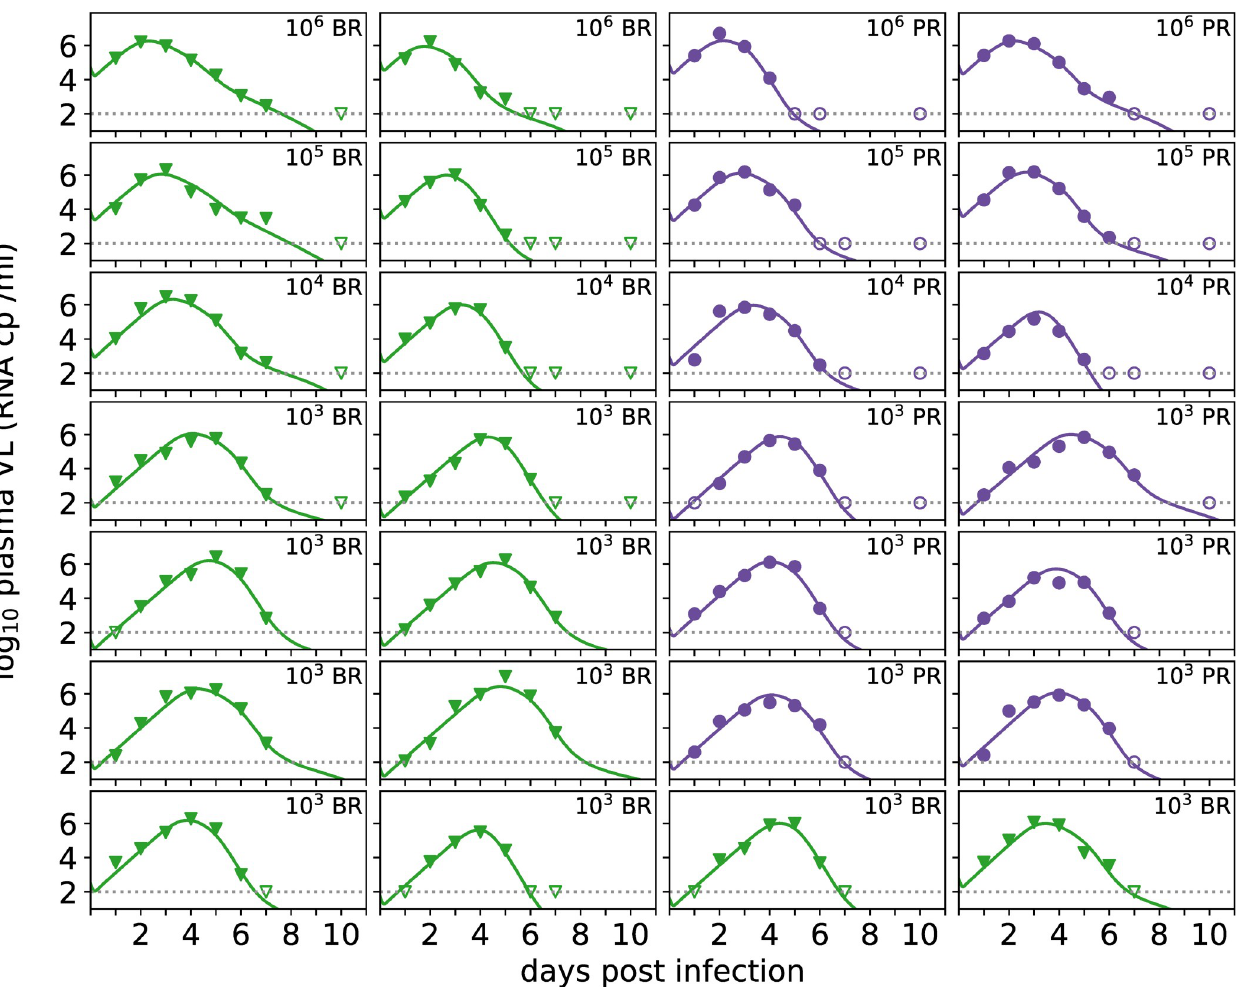
Fig 3. Individual viral load predictions from population model fits. For each animal the observed plasma viral loads (markers), the predicted viral load from the immune response model with viral interference (Eq 3, Table 1) are shown. The horizontal grey dotted line represents the limit of detection of the assay, and samples in which virus is not detected are shown with open markers at this value. Viral strain is indicated by marker and color (BR: green triangles, PR: purple circles) and both inoculum dose and viral strain are indicated in the top right corner of each